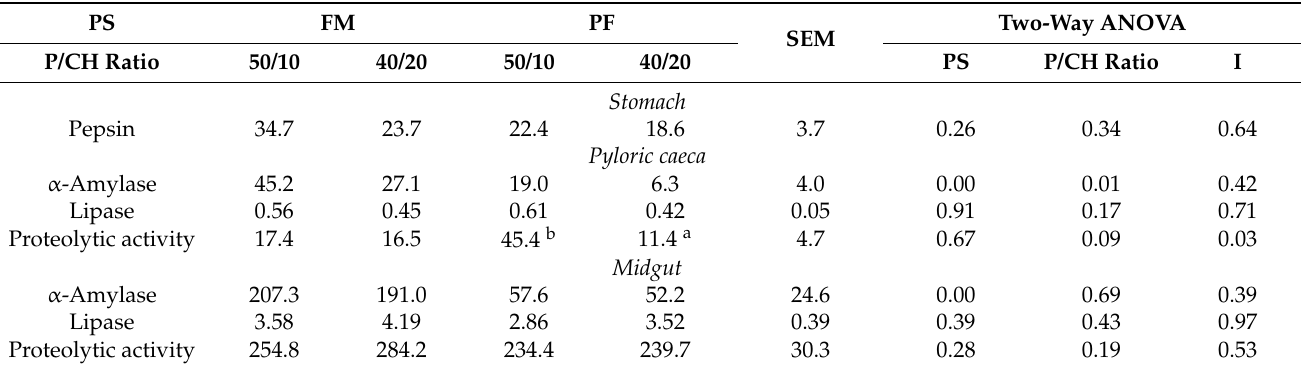
Table 6. Specific activity of pepsin (U mg protein − 1 ) in the stomach, and α -amylase, lipase (mU mg protein − 1 ), and proteolytic activity (U mg protein − 1 ) in the pyloric caeca, and midgut of gilthead seabream fed the experimental